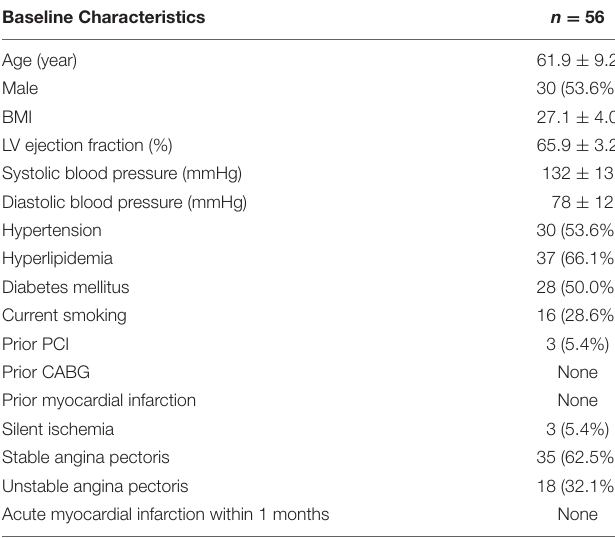
TABLE 1 | Baseline characteristics of the study